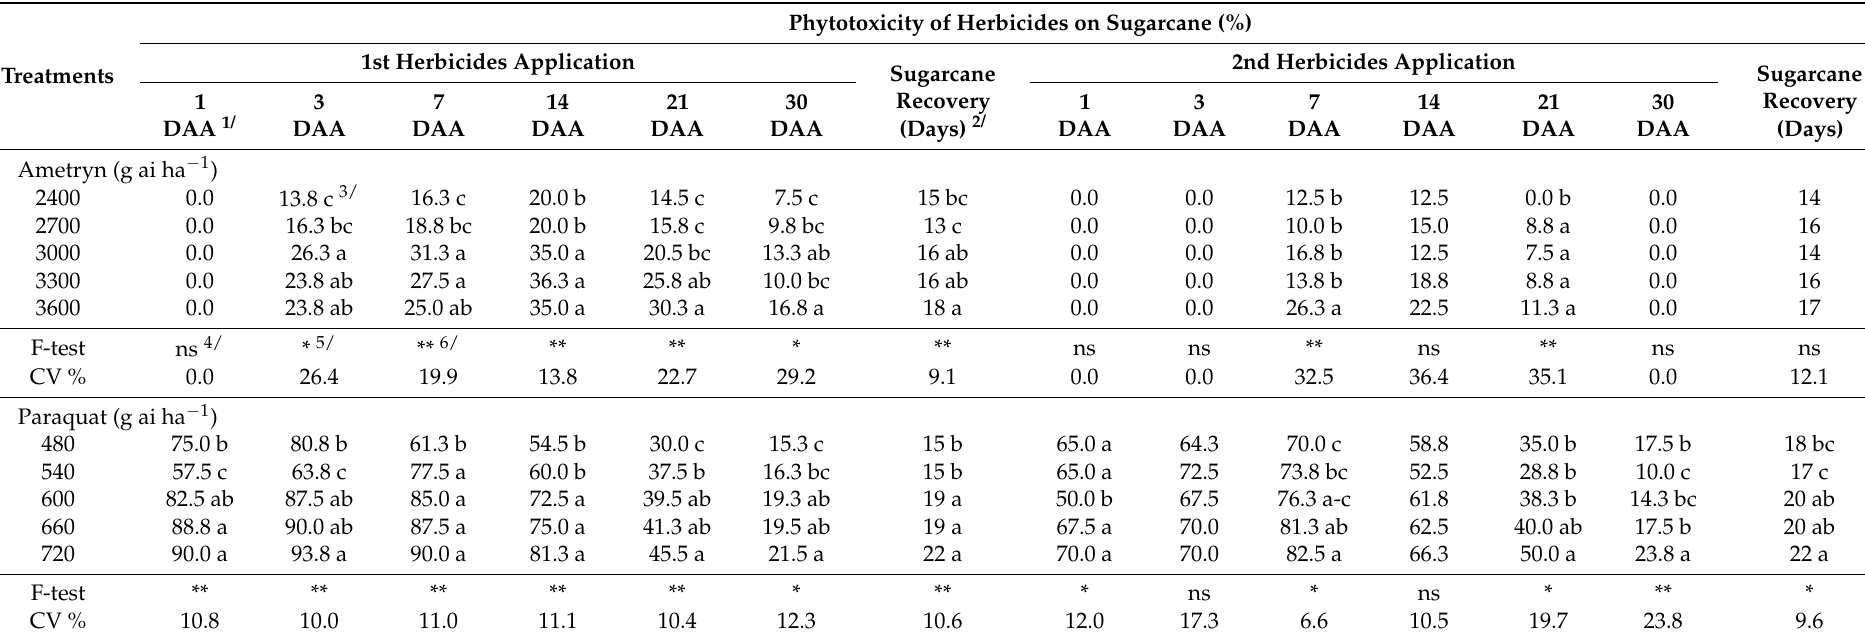
Table 4. Effects of ametryn and paraquat applications at various rates in Experiment II on phytotoxicity of herbicides on sugarcane and sugarcane recovery in the first and second herbicide